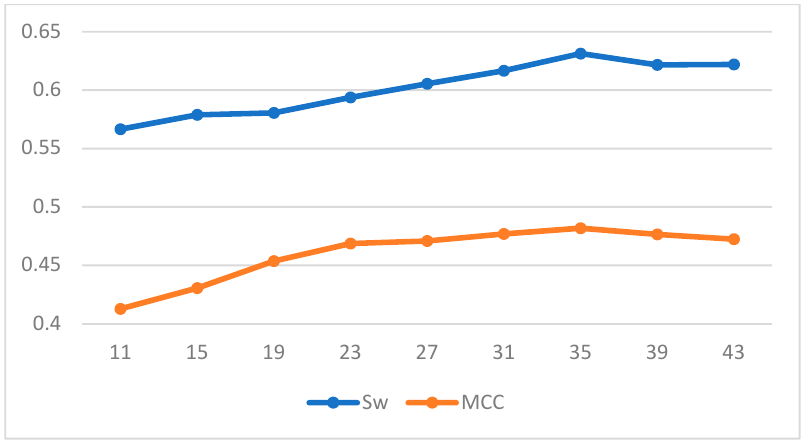
Figure 2. Effect of different window length on prediction performance of LDA.